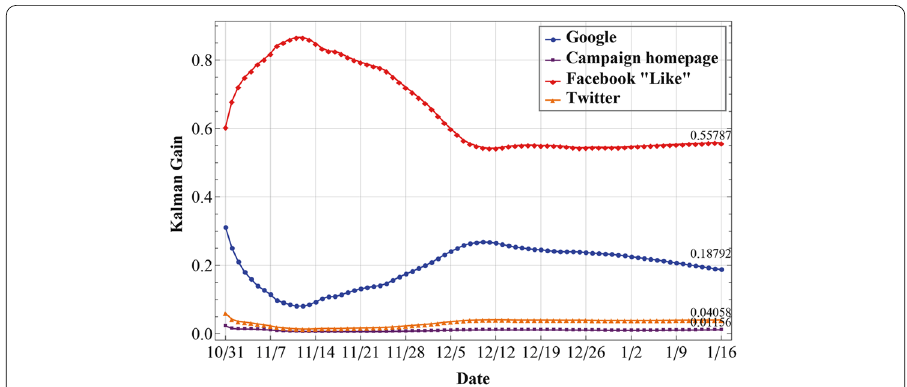
Figure 3 Kalman gain for different online signals. The Kalman gain of the Facebook “Like” constitutes the highest proportion but gradually decreases while the Google signal continuously increases. Twitter and the campaign homepages are not indicative signals for the election. The Kalman gains of all the signals converge to steady states approximately one month before the